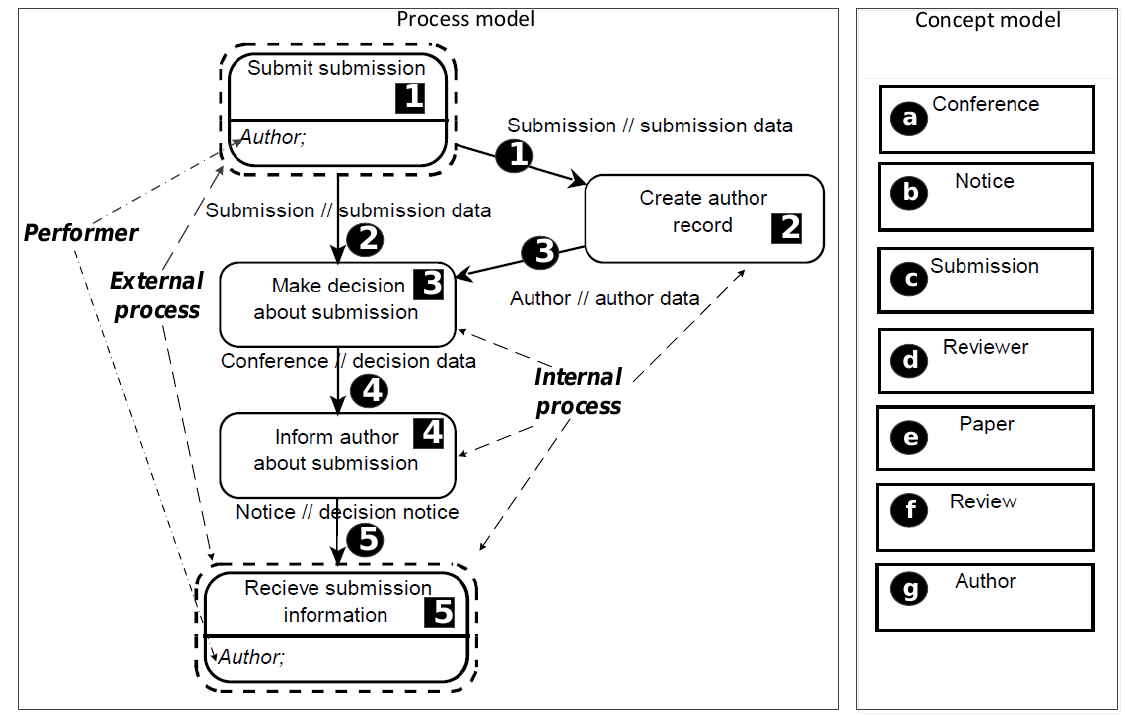
Fig. 1. The fragment of the two-hemisphere model for conference support